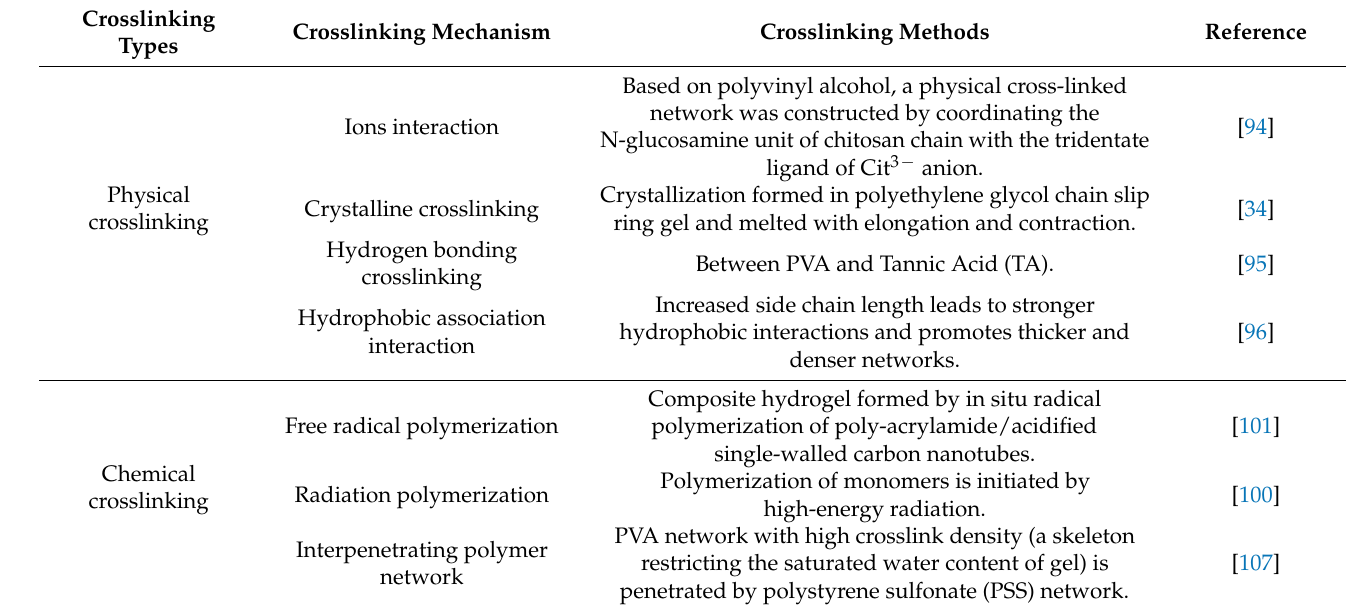
Table 3. Classification of hydrogel crosslinking